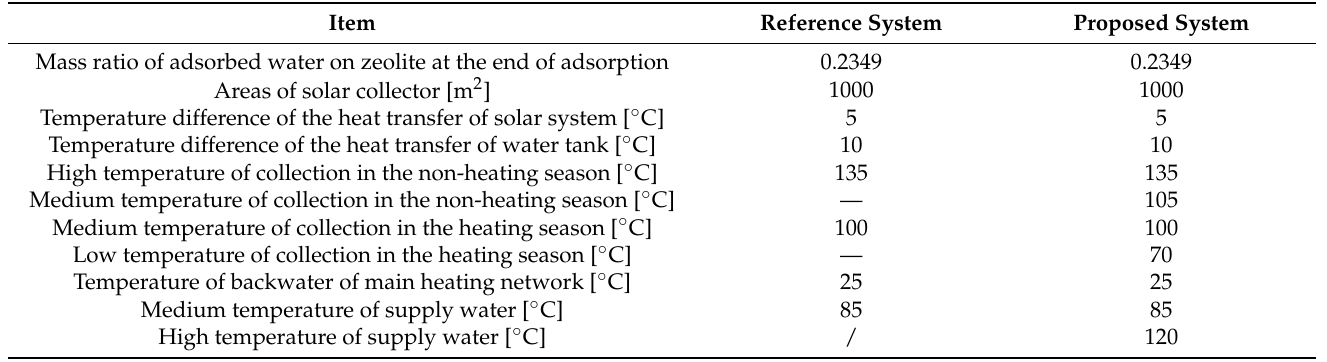
Table 7. Performances of the proposed and reference